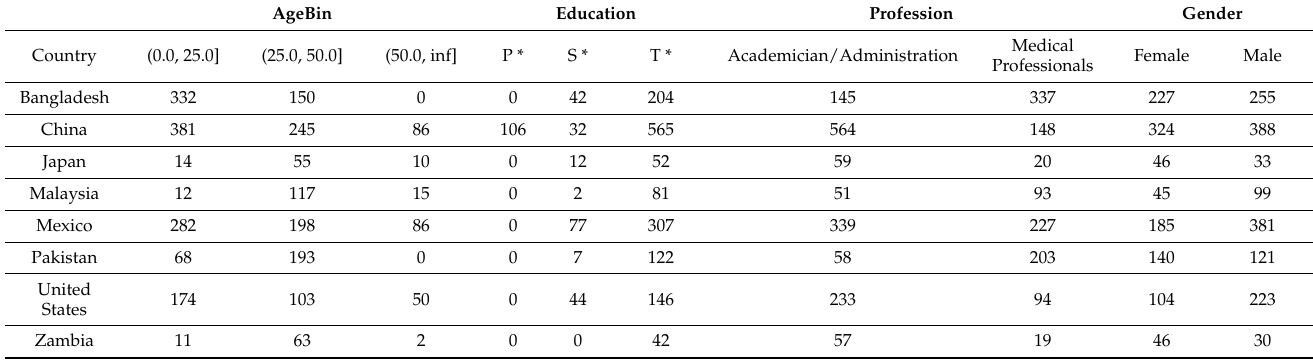
Table 1. The number of respondents of different subgroups across the different countries.